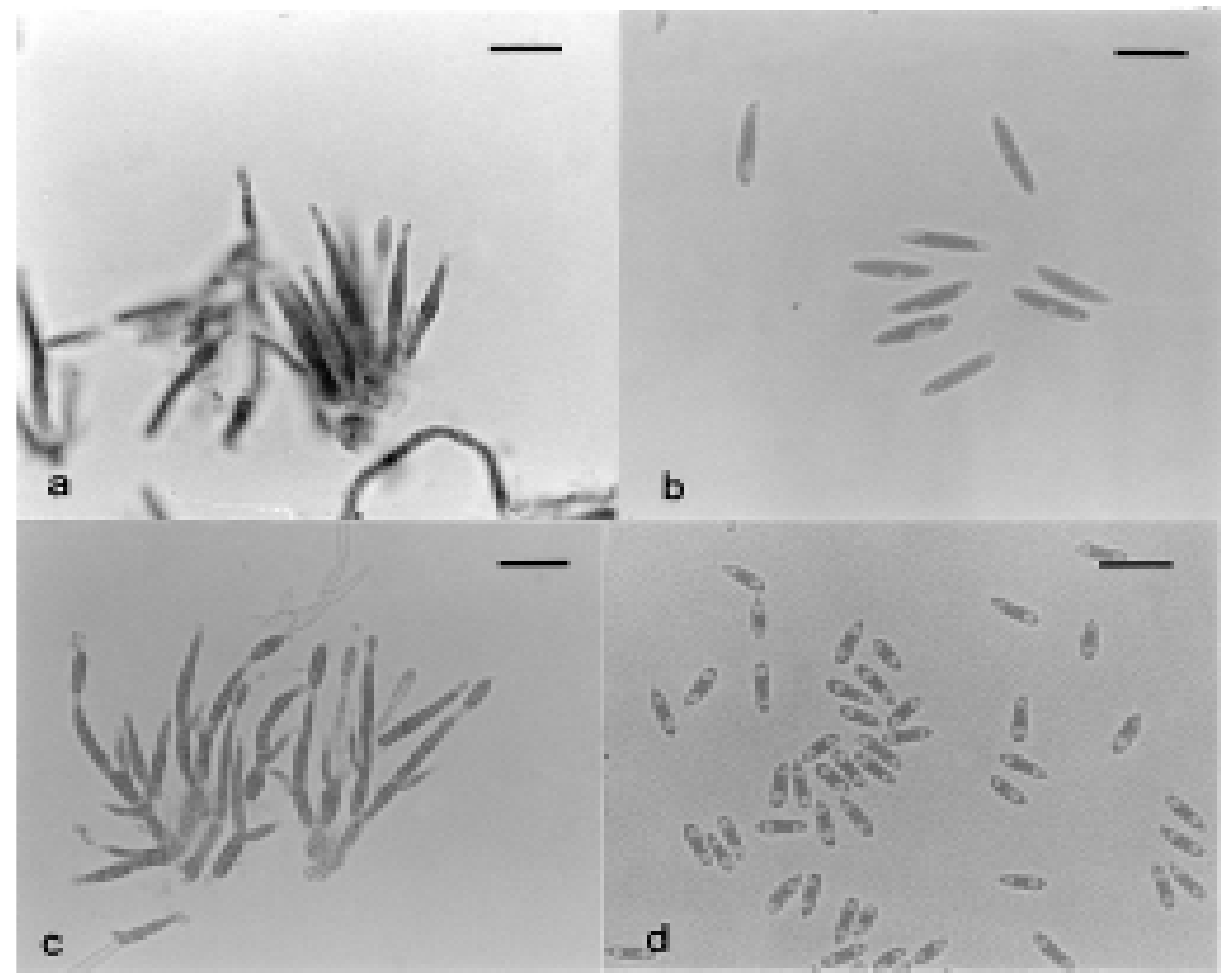
Fig. 5. Conidia and conidiophores of Phomopsis species from grapevines. a. and b., P. viticola . c. and d., Phomopsis anamorph of Diaporthe perjuncta . Scale bars = 10 µ